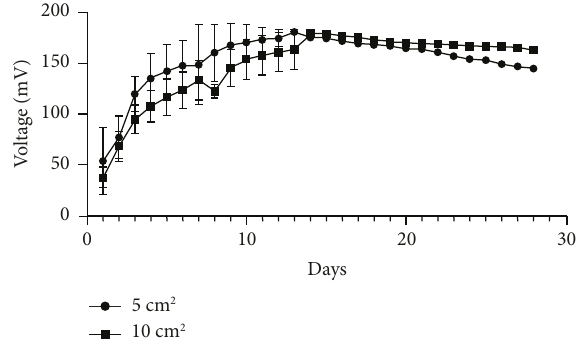
Figure 5: The effect of the surface area on voltage (mV ± SD) output by H. salinarum over 28 days at 37 ° C without oscillation. Each data point is the daily average voltage (mV) recorded every 30 minutes from 1–4 separate experiments. Electrode surface area had no effect ( p � 0 . 5944) on voltage under nonoscillating conditions based on an unpaired T -test with Welch